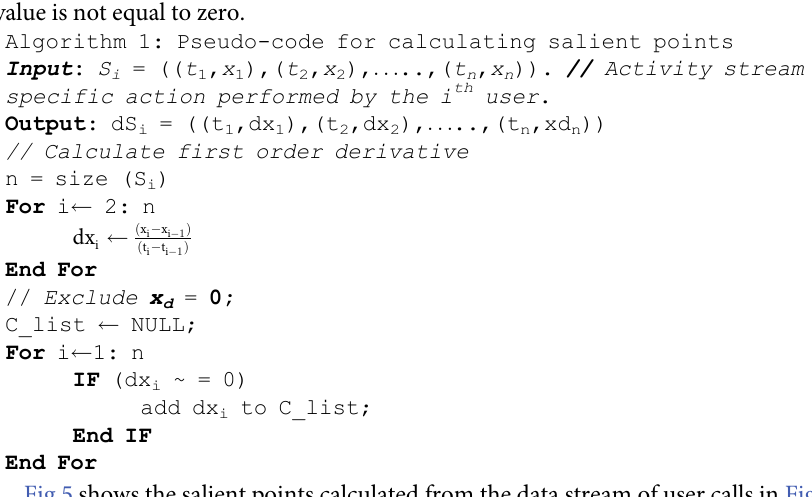
Algorithm 1: Pseudo-code for calculating salient